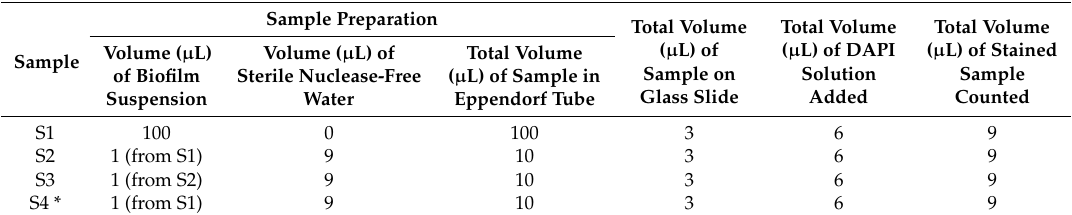
Table 1. Volumetric description of sample preparation (S1, S2 and S3) and subsequent staining for counting bacterial cells using epifluorescence microscopy.